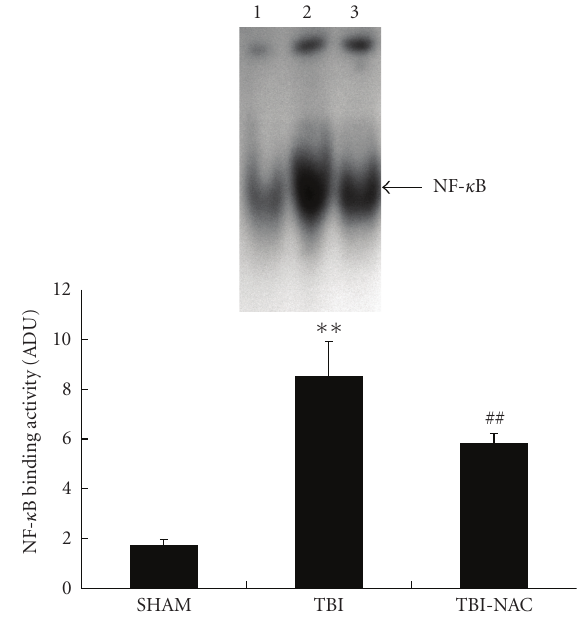
Figure 2: NF- κ B activity in the brain area surrounding the injury site in SHAM group ( n = 5), TBI group ( n = 6), and TBI-NAC group ( n = 6). (Upper) EMSA autoradiography of NF- κ B DNA binding activity. (Bottom) levels of NF- κ B DNA binding activity quantified by computer-assisted densitometric scanning and expressed as arbitrary densitometric units (ADUs). As compared with SHAM group, NF- κ B binding activity measured by EMSA was significantly increased in TBI group. Compared to TBI group, NAC significantly suppressed NF- κ B activation in TBI-NAC group. ∗∗ P < . 01 versus SHAM group, ## P < . 01 versus TBI